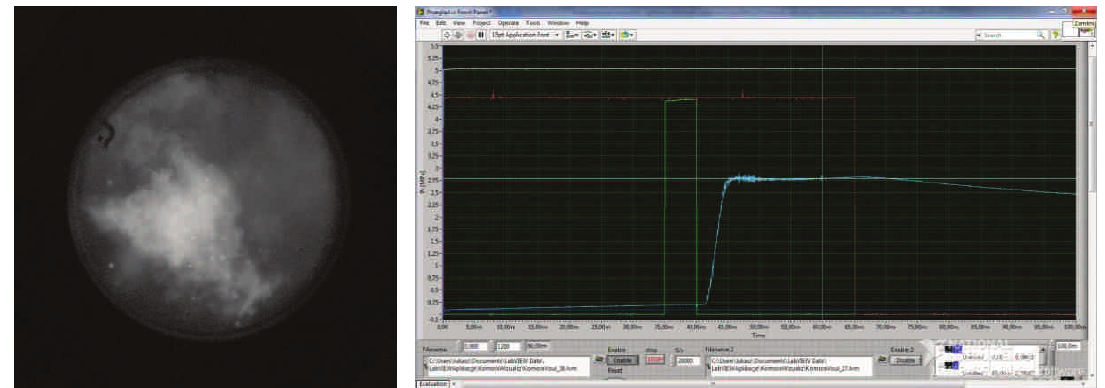
Fig. 5b. Photo of combustion stage and pressure course with marked pressure value 20 ms after combustion initiation. Combustion initiation – 40ms after opening of